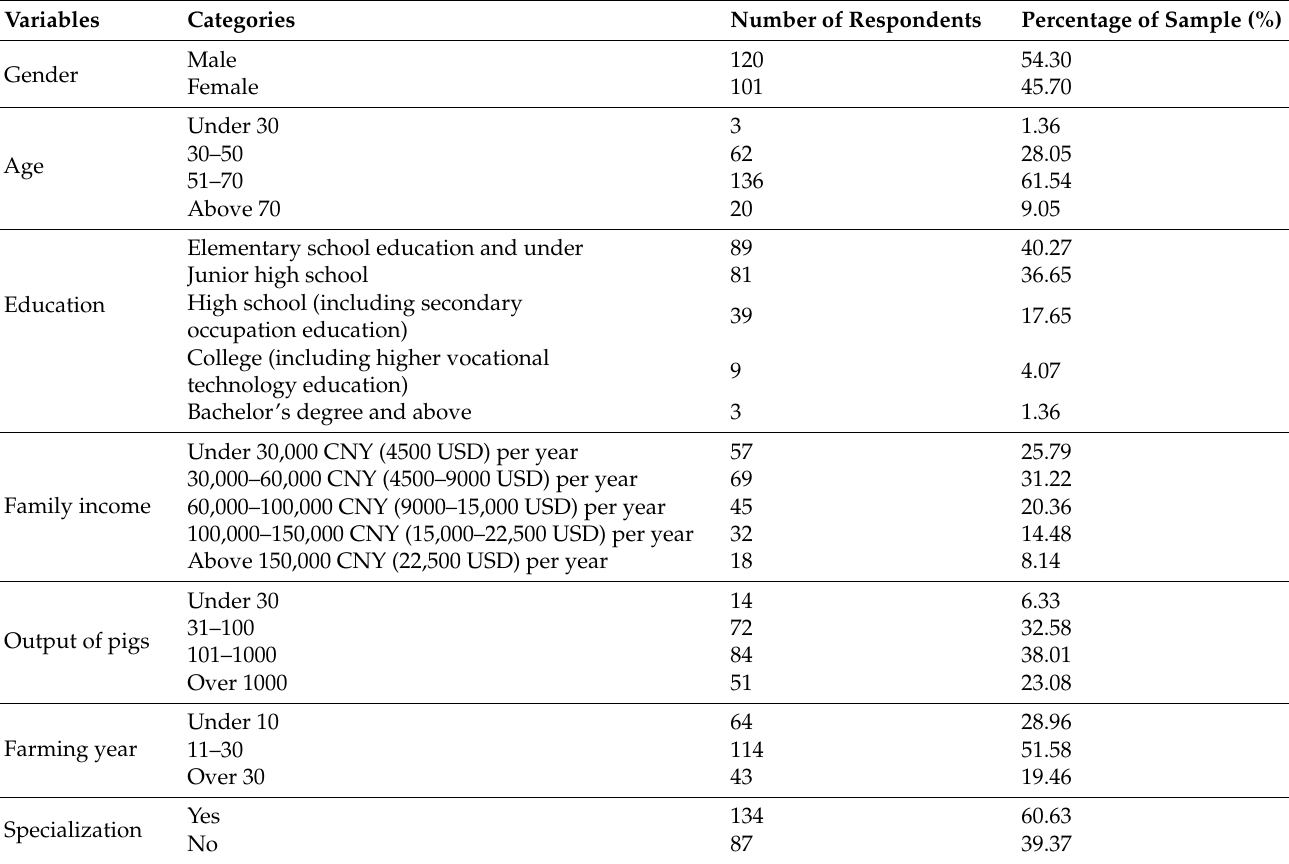
Table 2. Descriptive statistics of sample